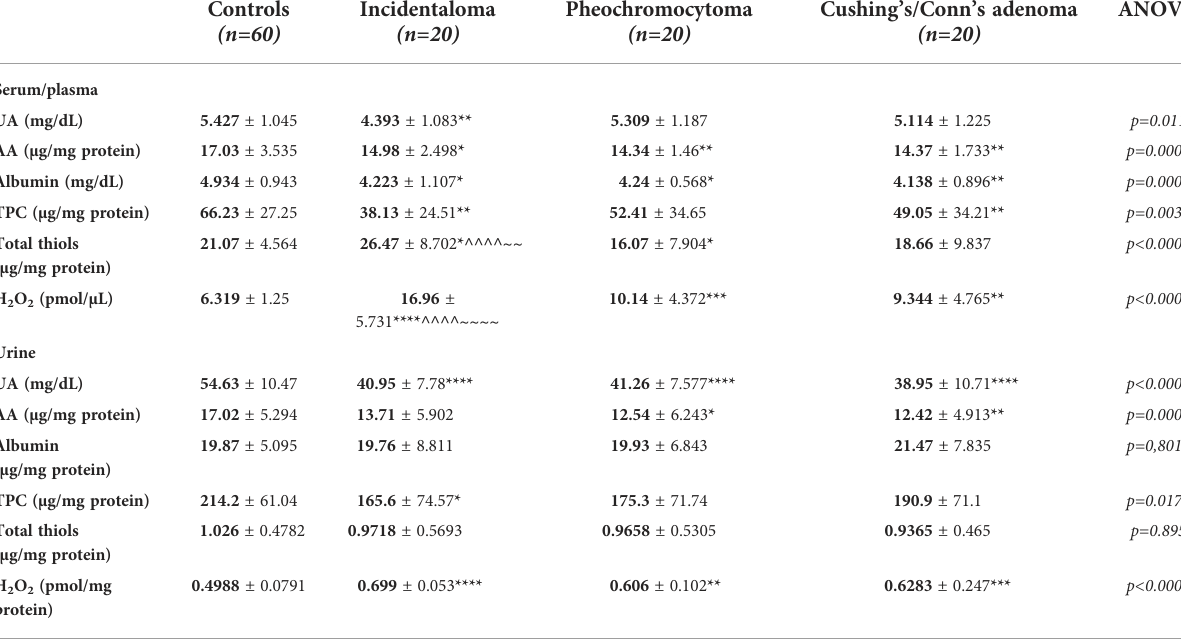
TABLE 2 The serum/plasma and urine concentration of selected antioxidants and hydrogen peroxide of the controls, incidentaloma, pheochromocytoma, and Cushing ’ s/Conn ’ s adenoma patients. Controls